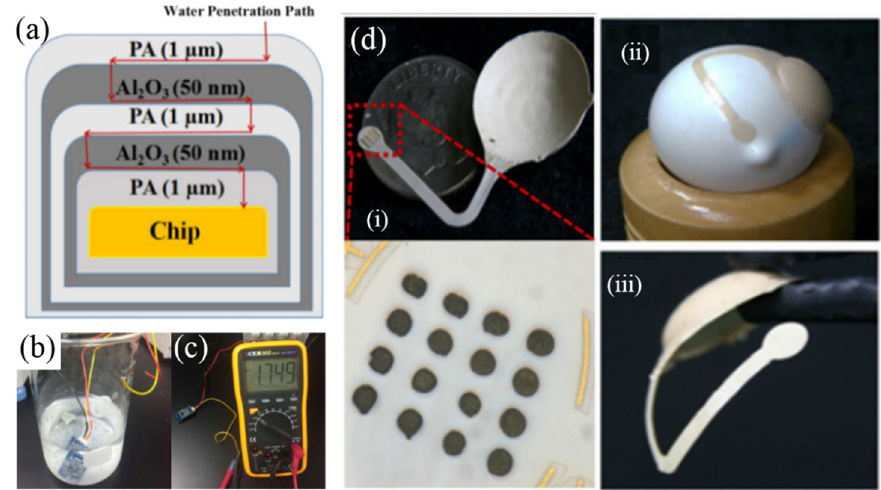
Figure 5. ( a ) Schematic diagram of the five-layer PA / Al 2 O 3 / PA / Al 2 O 3 / PA film on a sensor IC; ( b ) active soaking test for the film-coated humidity sensor at 87 ° C; ( c ) measurement setting of the humidity sensor after active soaking test; ( d ) fabricated LCP-based retinal prosthesis: (i) comparison with a dime and the inner surface, and magnification of the retinal electrode array coated by iridium oxide, (ii) the device on a model eye showing conformal attachment, (iii) electrode part was precurved to fit the eye-curvature. Reproduced with permission from [55], published by IEEE, 2015.